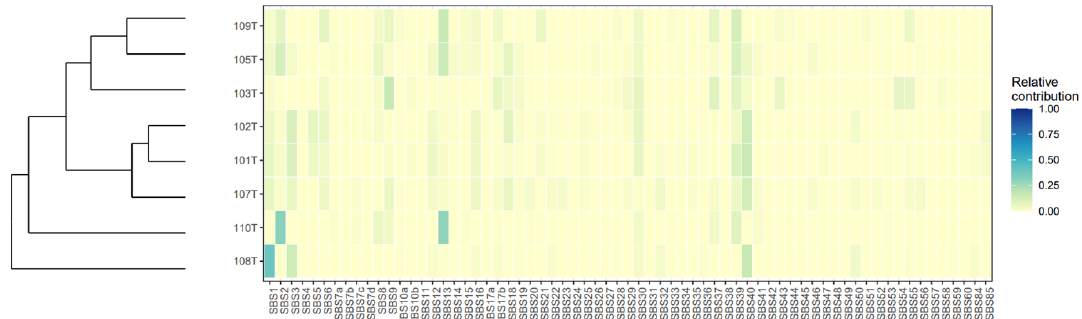
Figure 3. Mutational signature heatmap in anaplastic thyroid carcinoma. Single base substitution (SBS) signatures as defined by